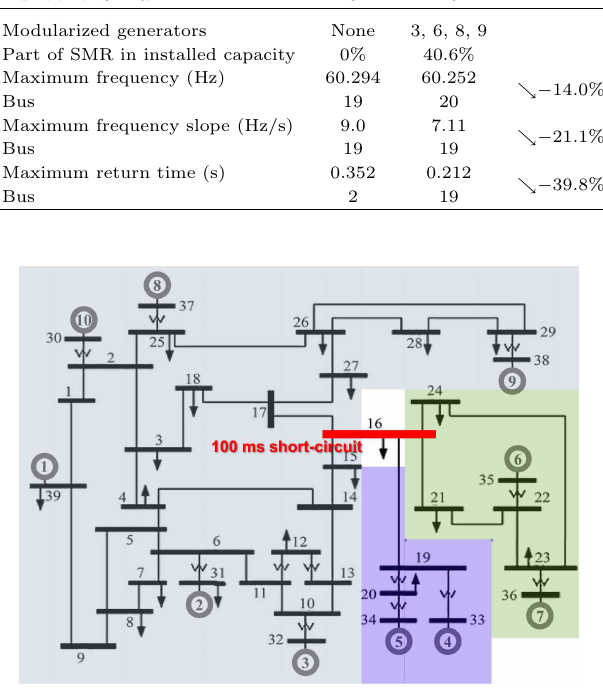
Fig. 17. Illustration of three zones next to the short-circuit bus